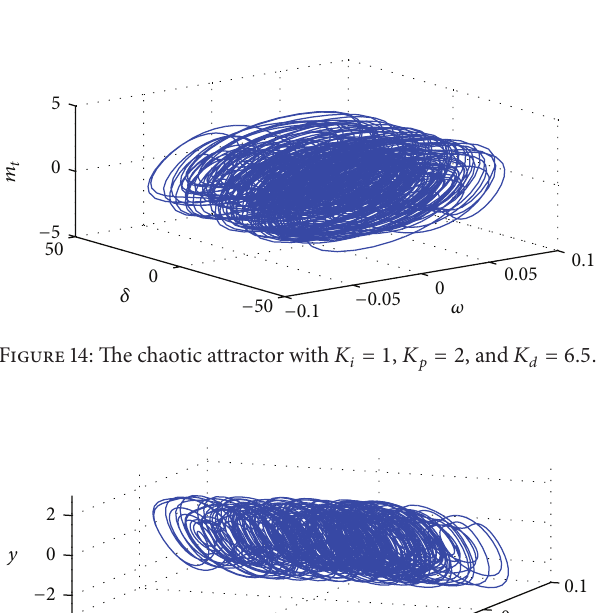
Figure 13: Stability domain, limit cycles, and chaotic region of 𝐾 𝑝 , 𝐾 = 1 . 𝐾 𝑑 with 𝑖